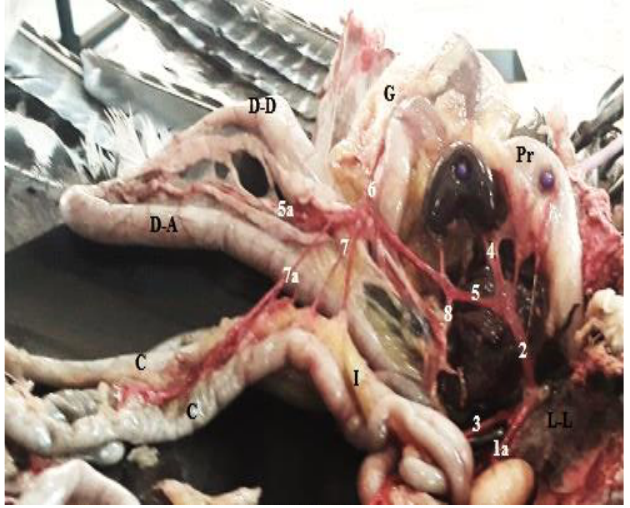
Figure 4. Photograph illustrates the branches of the celiac artery,3: cranial mesenteric artery;5: Right celiac a. 5a: pancreaticoduodenal ,7,7a : ileocecal branches a.,7&7a:cecalbranchs, 8: jejunal a.; 11: ileal a. A-D& D-D: ascending and descending duodenum